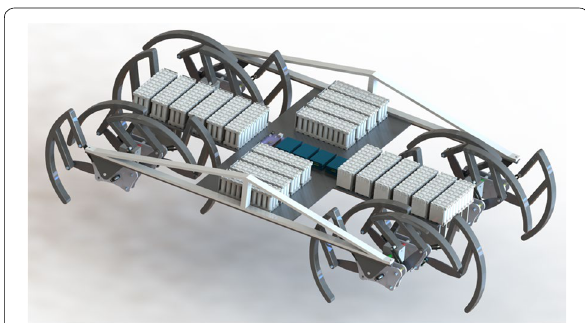
Figure 8 Layout of wheel-leg mobile platform